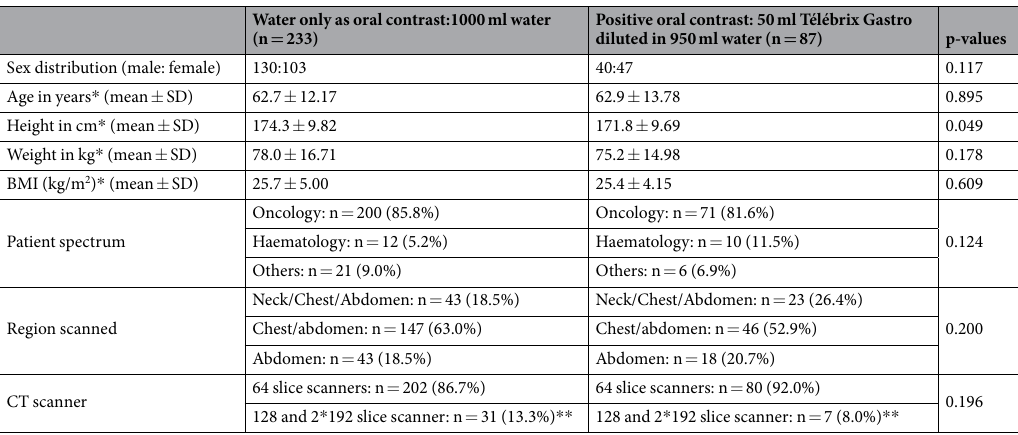
Table 1. Baseline patients and CT characteristics. * Age, height, weight, BMI and time interval were normally distributed. ** Due to the low number of patients scanned on the 128 and 2 * 192 slice scanners, these data were combined.